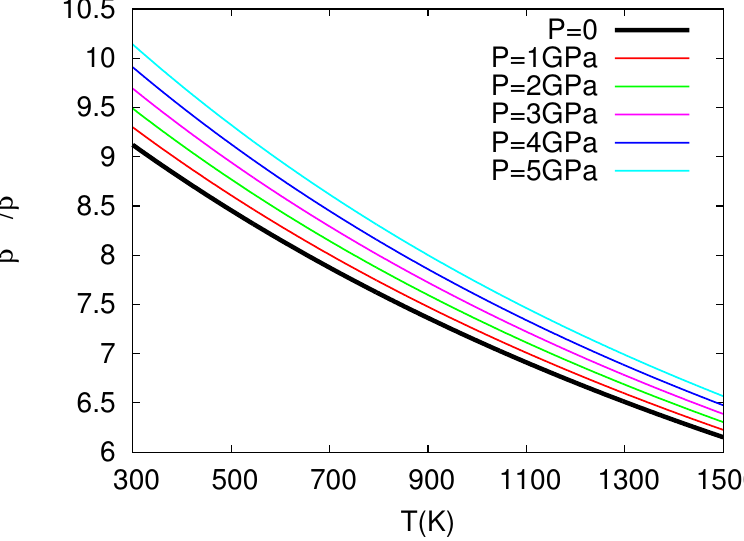
Figure 4. The β act / β values versus temperature (P = const) plotted for several